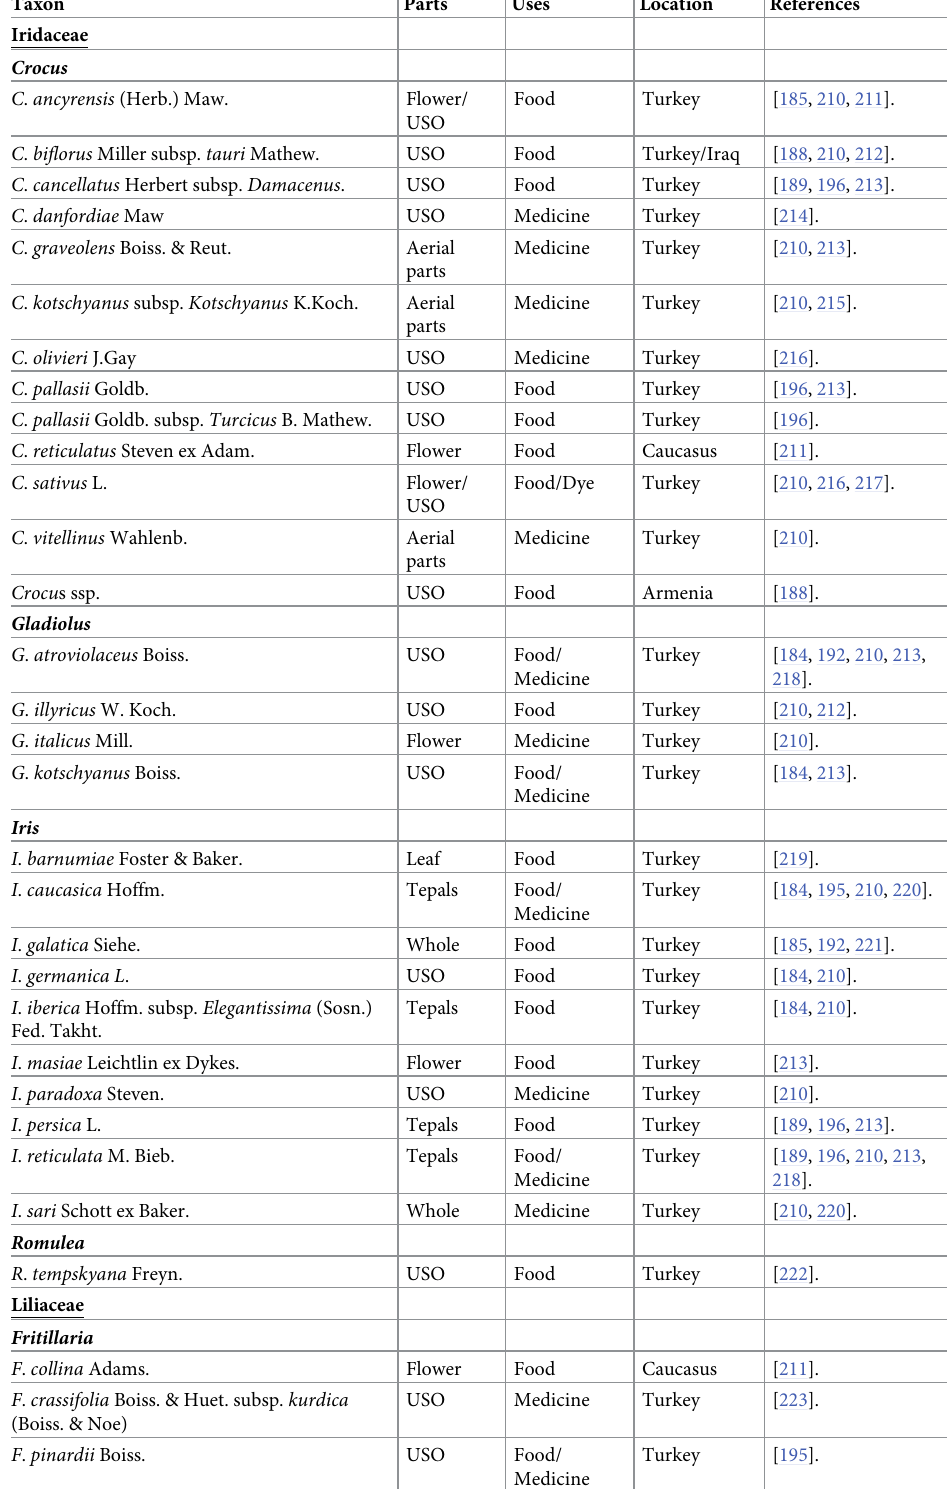
Table 5. Some economically important geophytes in Turkey and the surrounding